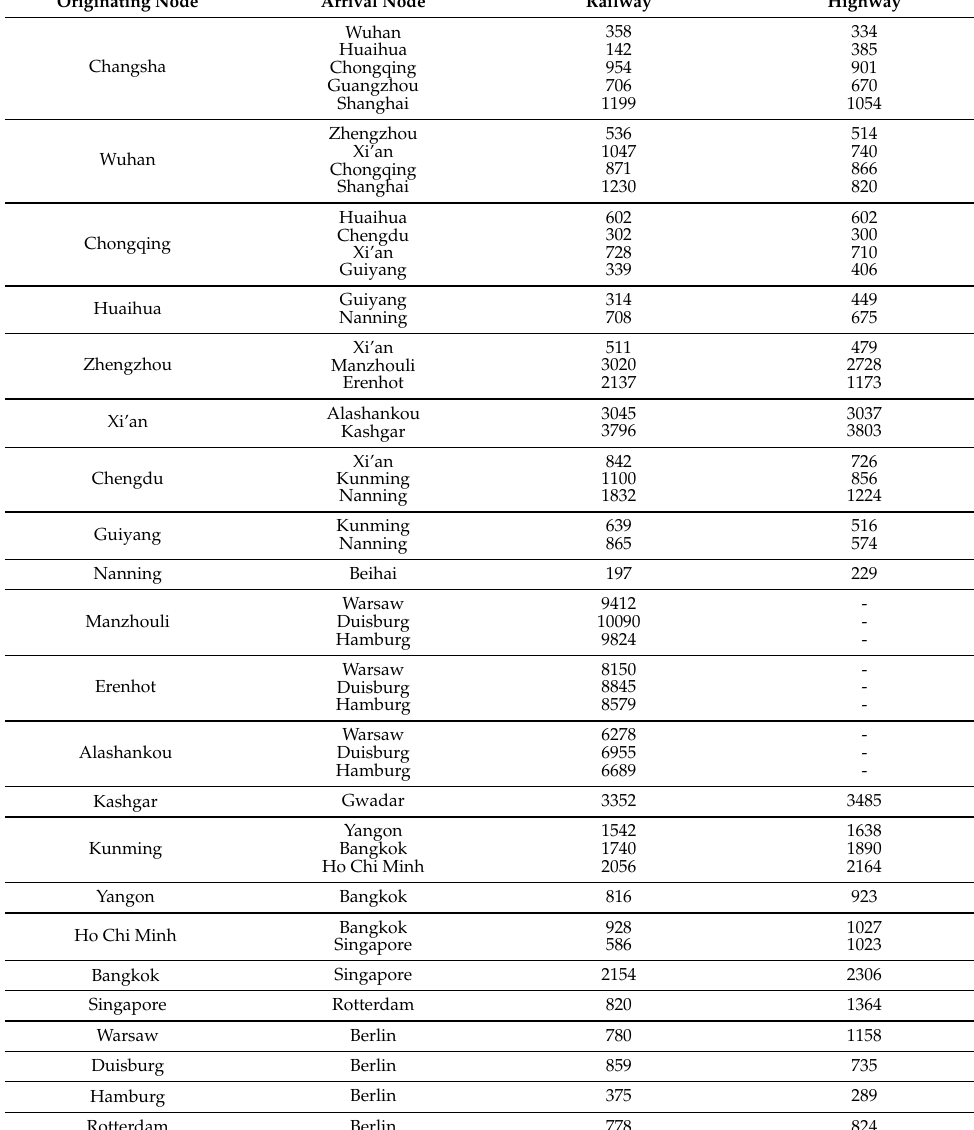
Table 5. Transport mileage of each mode of